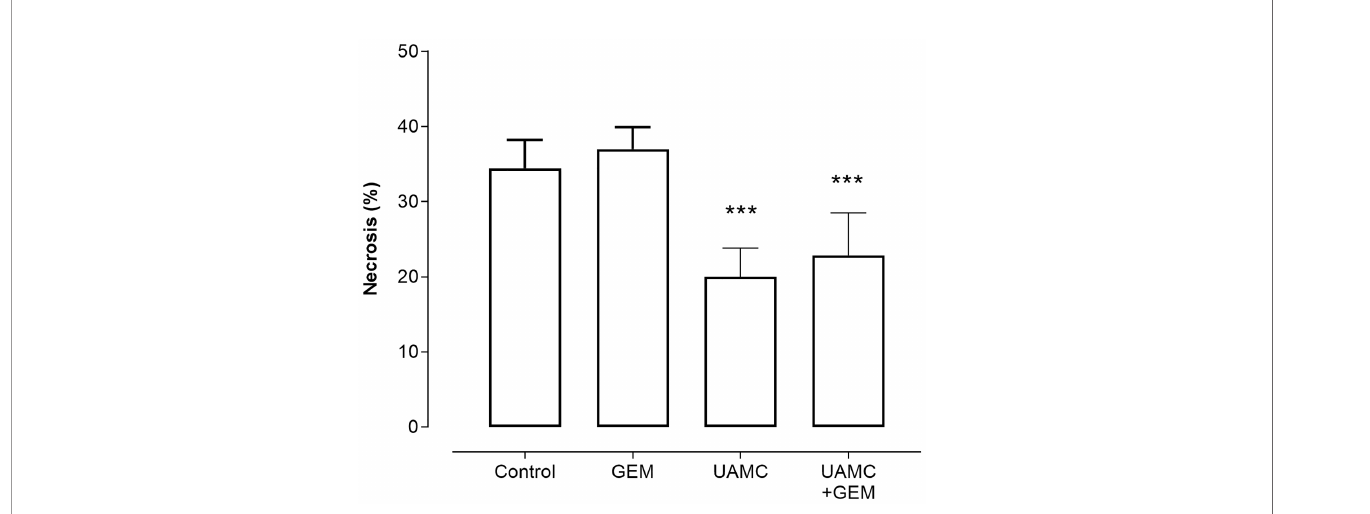
FIGURE 9 | Histological analysis of necrosis in Panc02 tumors. C57/BL6 mice with Panc02 tumors were treated with vehicle (control), UAMC-2526 (UAMC), gemcitabine (GEM) or a combination of UAMC-2526 and gemcitabine. After treatment samples were immunostained with hematoxylin-eosin. Number of animals in each group was between 8-10. Data were analyzed with factorial analysis of variance (ANOVA), ***p ≤ 0.001 with factors UAMC (p=0.001), GEM (p=0.499) and interaction UAMC by GEM (p=0.970).